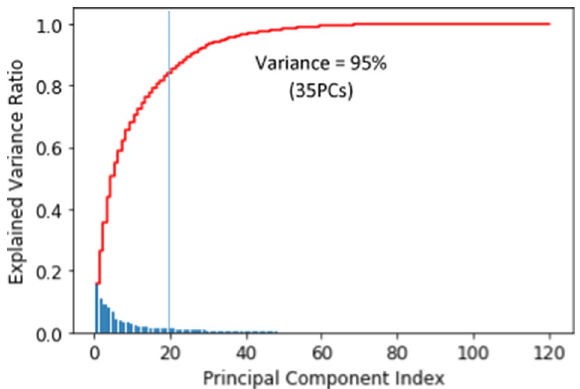
Fig. 5 Principal component index